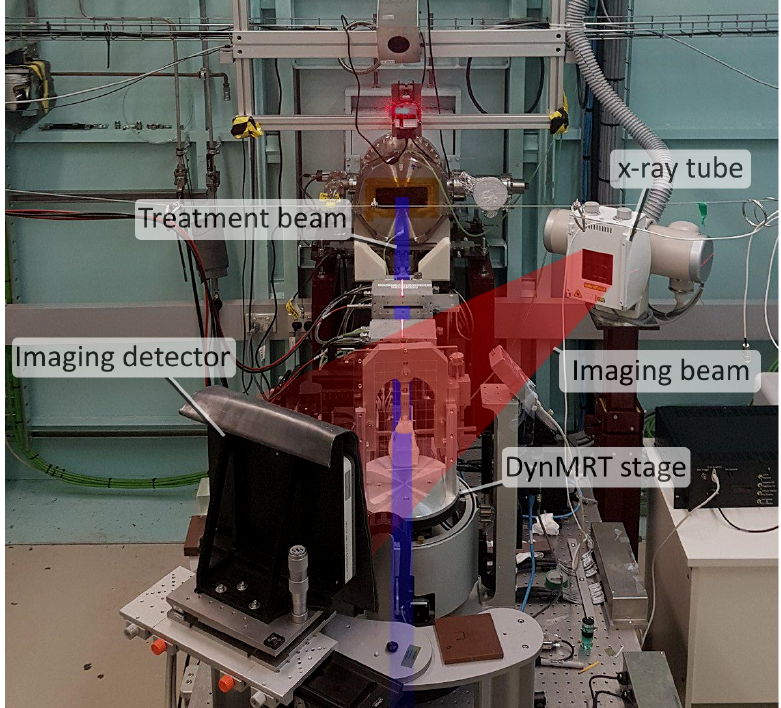
Figure 1. Setup of the treatment room (IMBL Hutch 2B) illustrating components relevant to image- guided MRT. The path of the treatment beam overlaid in blue travels from top to bottom of the image. The imaging beam produced by the orthovoltage X-ray tube is overlaid in